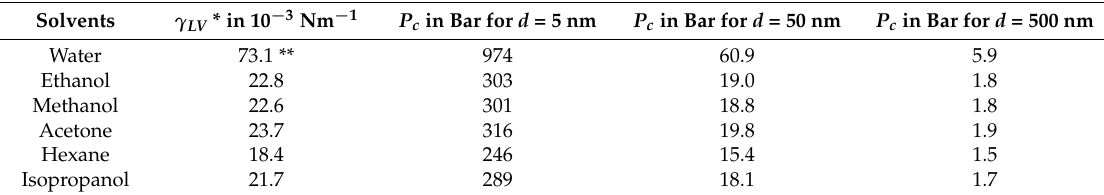
Table 1. Values of capillary tension for different solvents and pore sizes calculated for T = 20 °C and δ = 1 nm using Equation